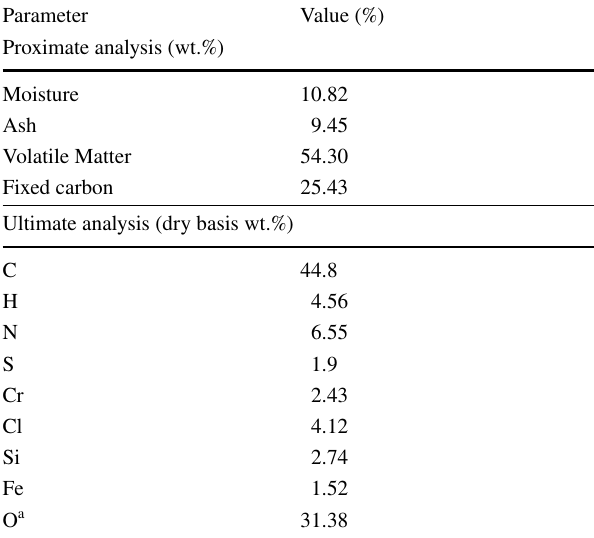
Fig. 1 The Adsorption Efficiency of MB by AC prepared at